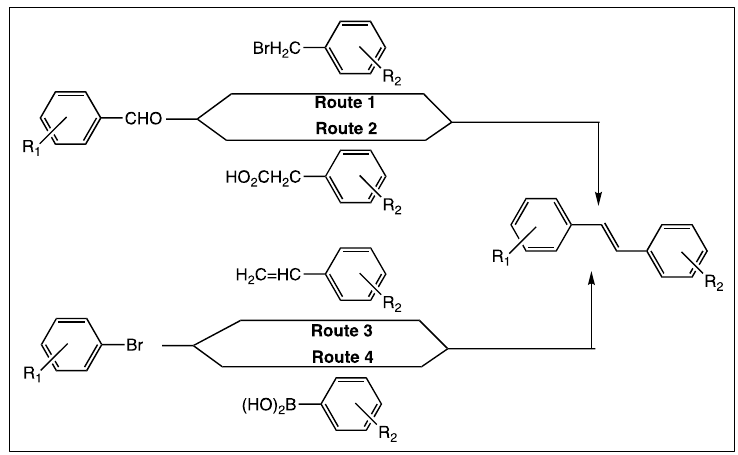
Figure 2. Principal synthetic methods for obtaining stilbene derivatives. Route 1: Wittig method [39,40], route 2: Perkin method [38], route 3: Heck method [39], route 4: Suzuki method [42].